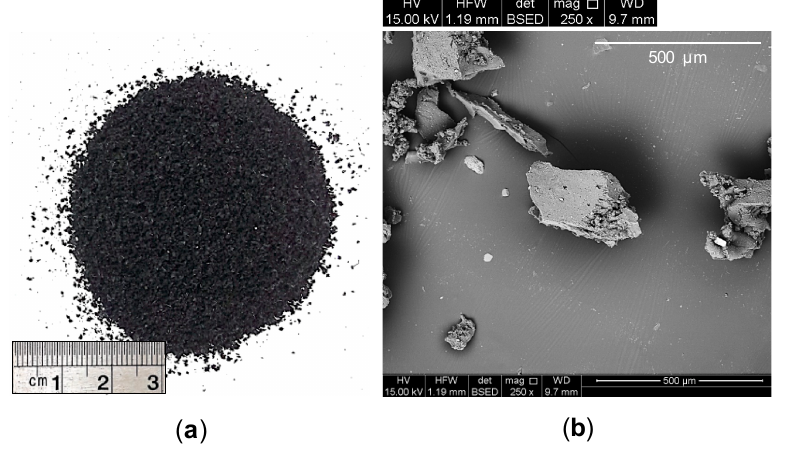
Figure 2. The ground rubber (GR) material at different magnification ratios of ( a ) 1× and ( b ) 250×.